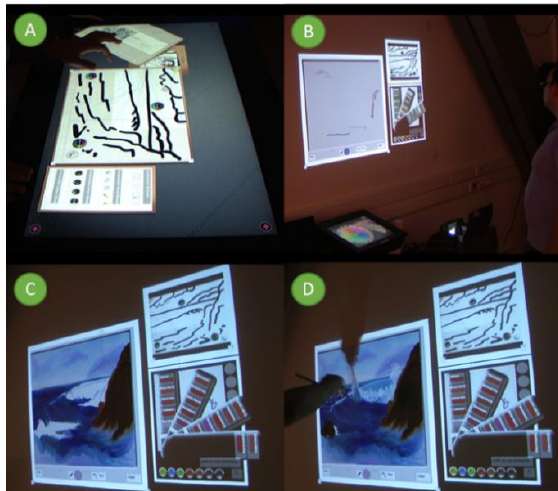
Figure 6. Intermediate steps for the creation a traditional geometric composition using the workshop.